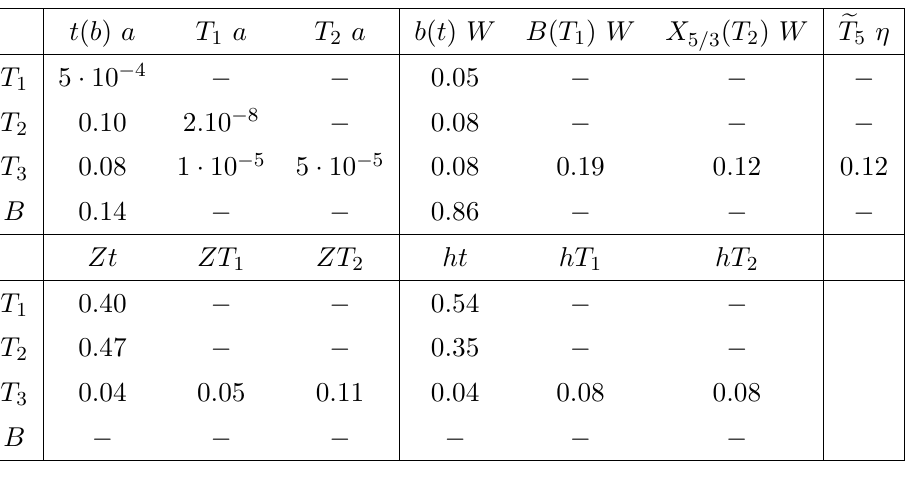
Table 2 . Same as in table 1 but for the benchmark model Bm2.